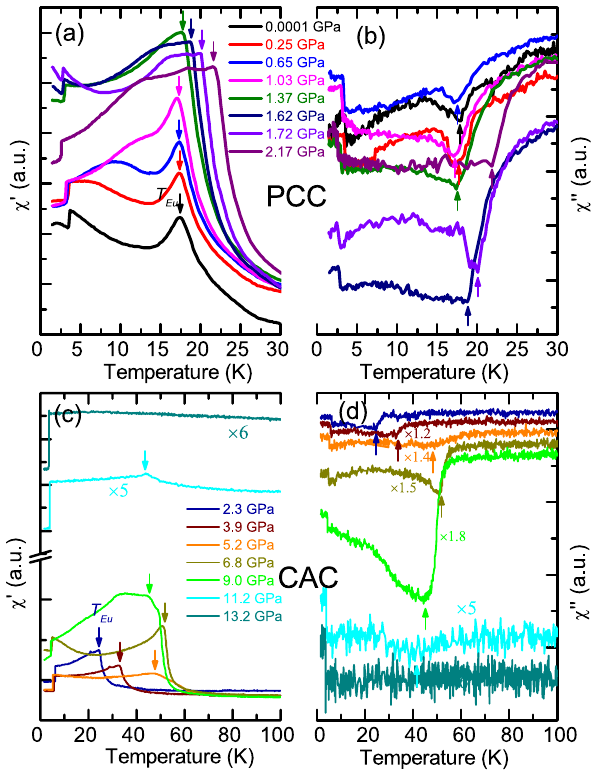
Figure 2. Temperature dependencies of the real and imaginary part of the ac magnetic susceptibility, χ ′ and χ ″ , of the Eu(Fe 0.925 Co 0.075 ) 2 As 2 single crystals measured under high pressures with the piston-cylinder cell ( a , b ) and the cubic anvil cell ( c , d ),